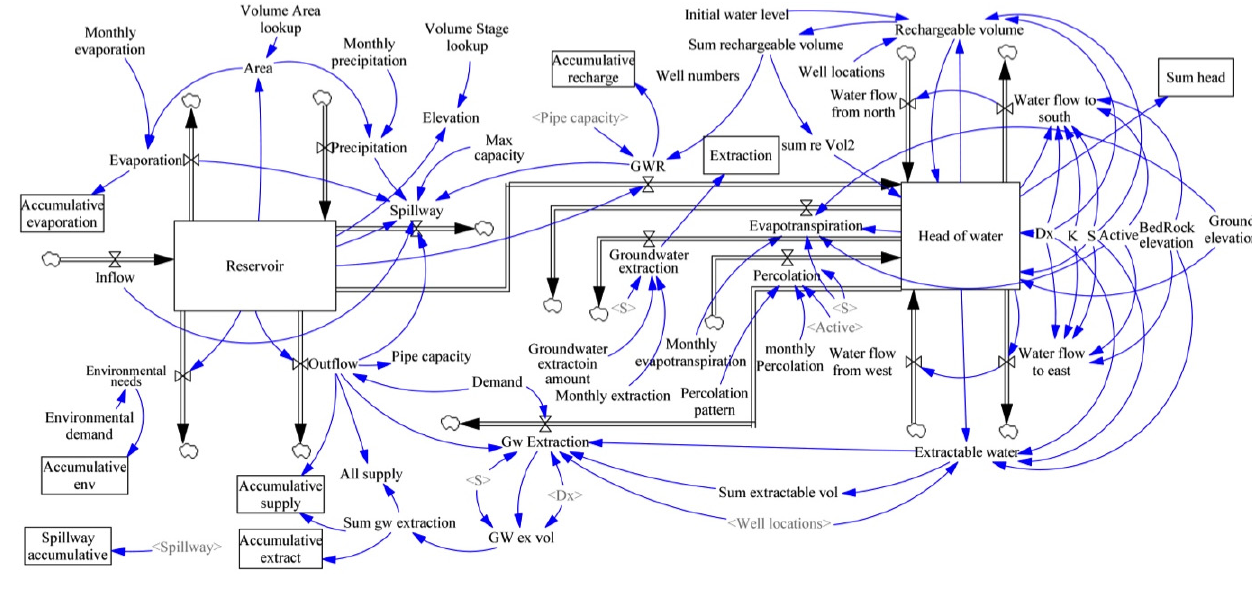
Figure 4. System dynamics model